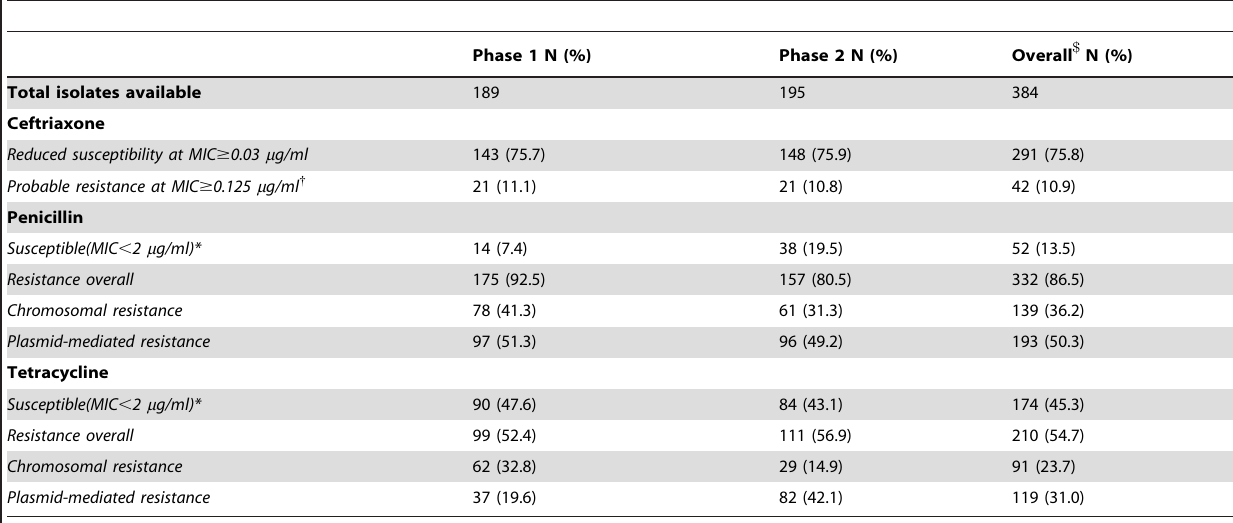
Table 3. Prevalence of resistance or reduced susceptibility to ceftriaxone, penicillin, and tetracycline in a sample of clients from the Shanghai Sexually Transmitted Infection and Skin Disease